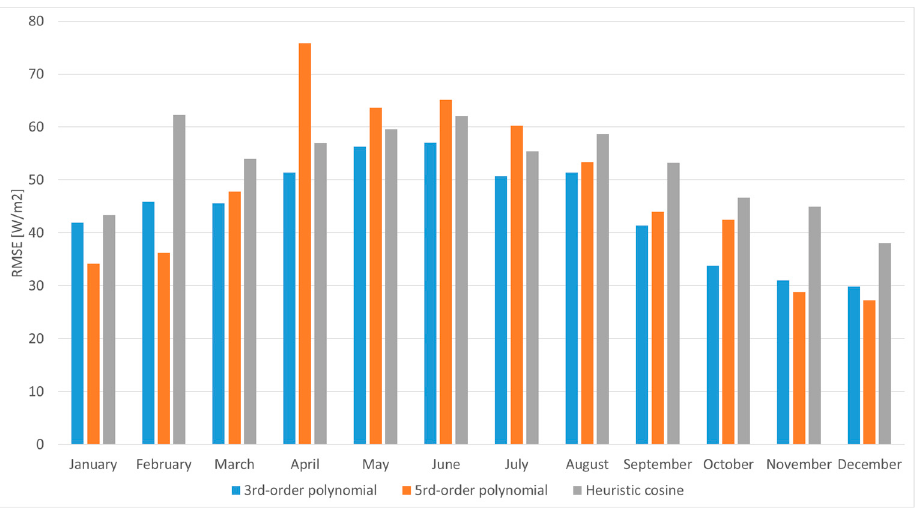
Figure 14. Root-mean-squared errors of resultant functions depending on the measurement month for an incidence angle greater than 10°.